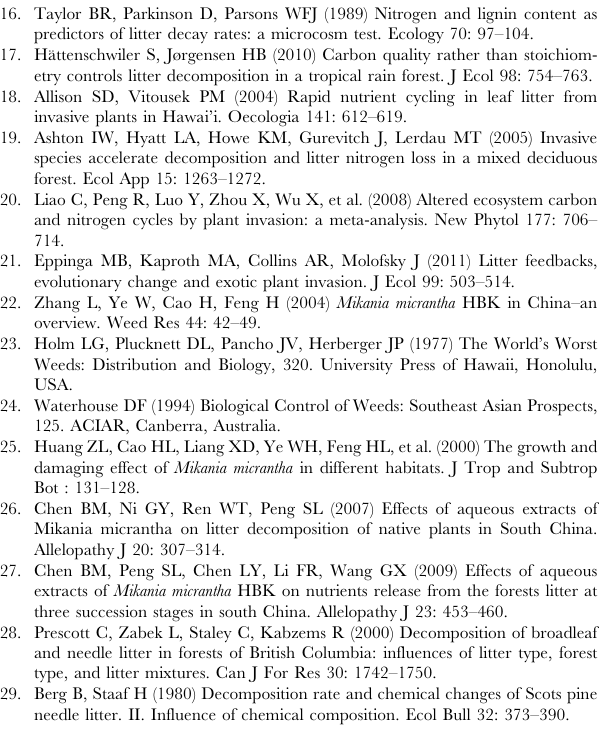
Table S1 The analyses of litter mass loss among 8 single species over each decay time by ANOVA.